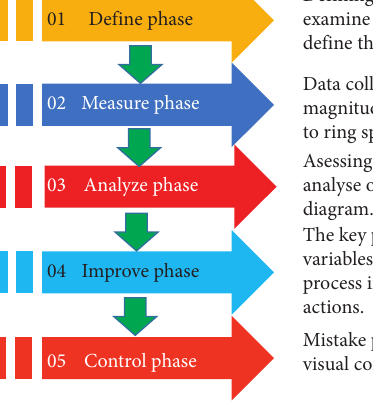
Figure 1: Methodological approach of the research.